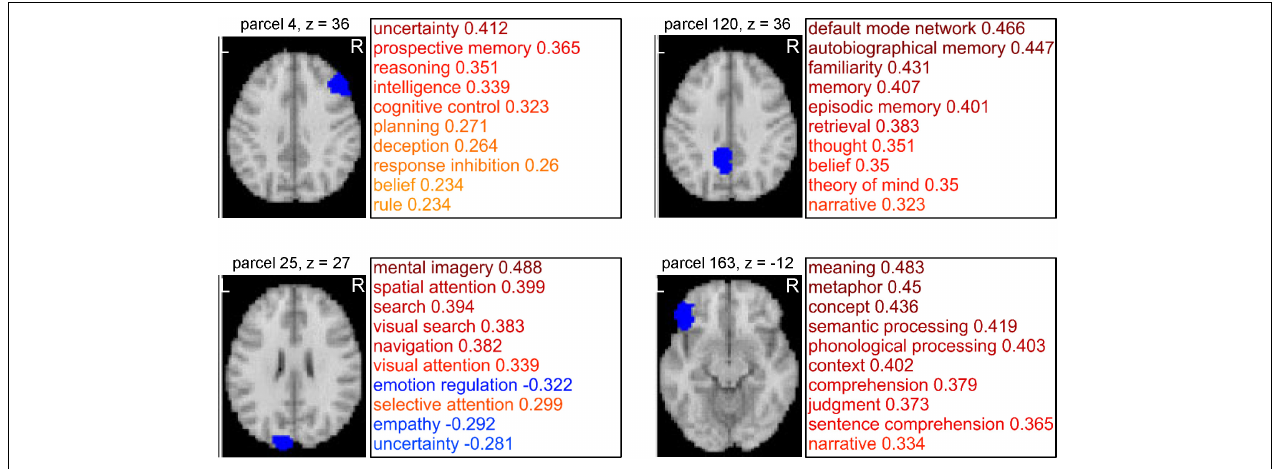
FIGURE 4 | Examples of parcels resulting from cognitive function-based whole-brain parcellation. Four examples of the parcels. Maps on a standard brain (left in each parcel) and top 10 relatedness with cognitive functions (right in each panel) are shown. The relatedness was defined as mean voxel-to-cognitive function map resting-state functional connectivities over the voxels belonging to the